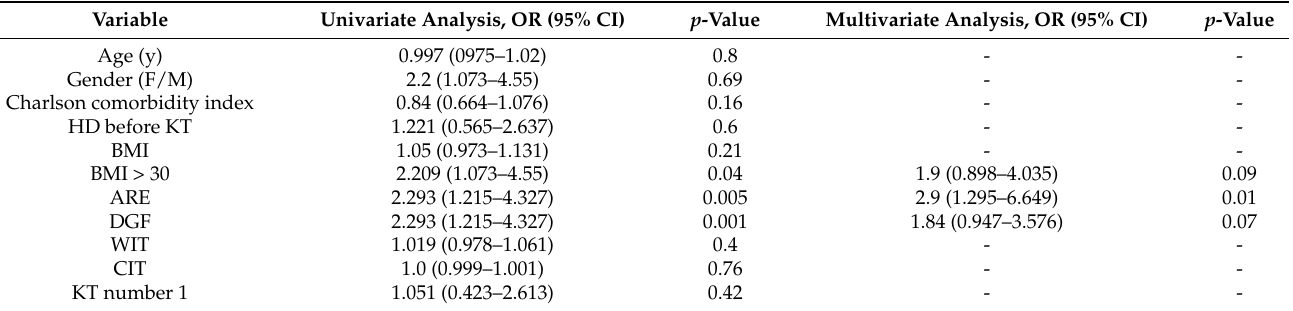
Table 3. Univariate and Multivariate Analysis of predictors of Graft’s Loss (Death Censored) in patients after kidney transplantation.